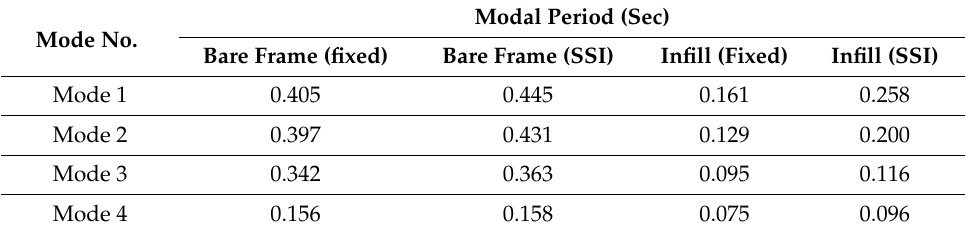
Table 4. Modal periods for various modeling scenarios.